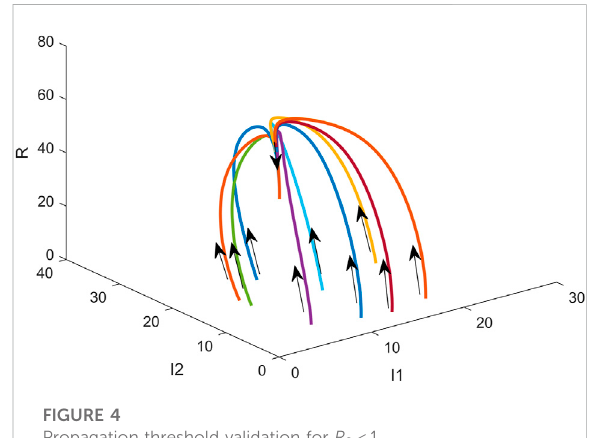
FIGURE 4 Propagation threshold validation for R 0 < 1.